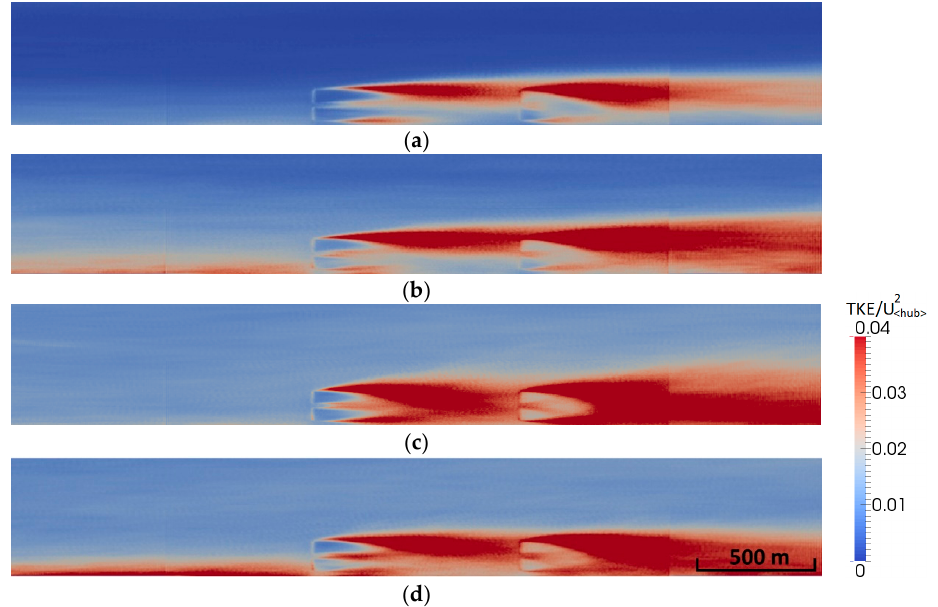
Figure 7. Streamwise cut of the turbulent kinetic energy (TKE) contours for ( a ) NLABL, ( b ) NHABL, ( c ) ULABL, and ( d ) UHABL along the centerline. Refer to Table 1 for acronyms.